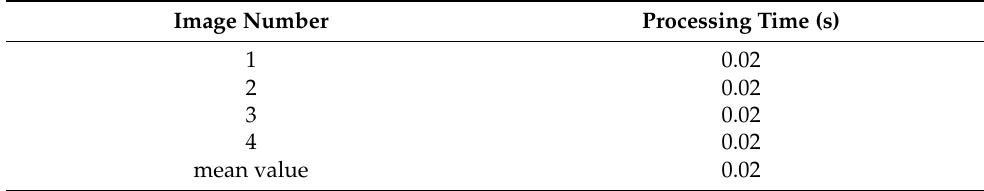
Figure 15. Contour feature positioning effect image under different illumination conditions (as Figure 9): ( a ) image under strong supplementary light source condition; ( b ) image under strong natural light conditions; ( c ) images under low natural light conditions; ( d ) image under weak supplementary light source condition. Table 3. Calculation times of contour feature